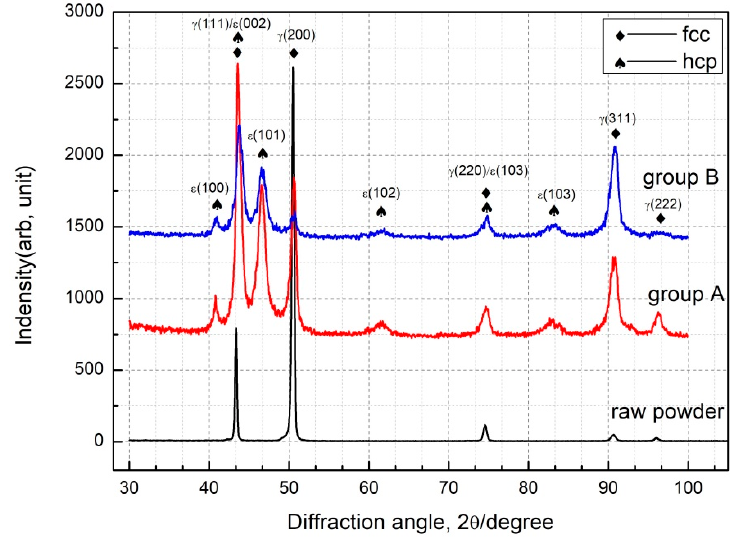
Figure 6. X-ray diffraction spectra of powder and deposited specimen.